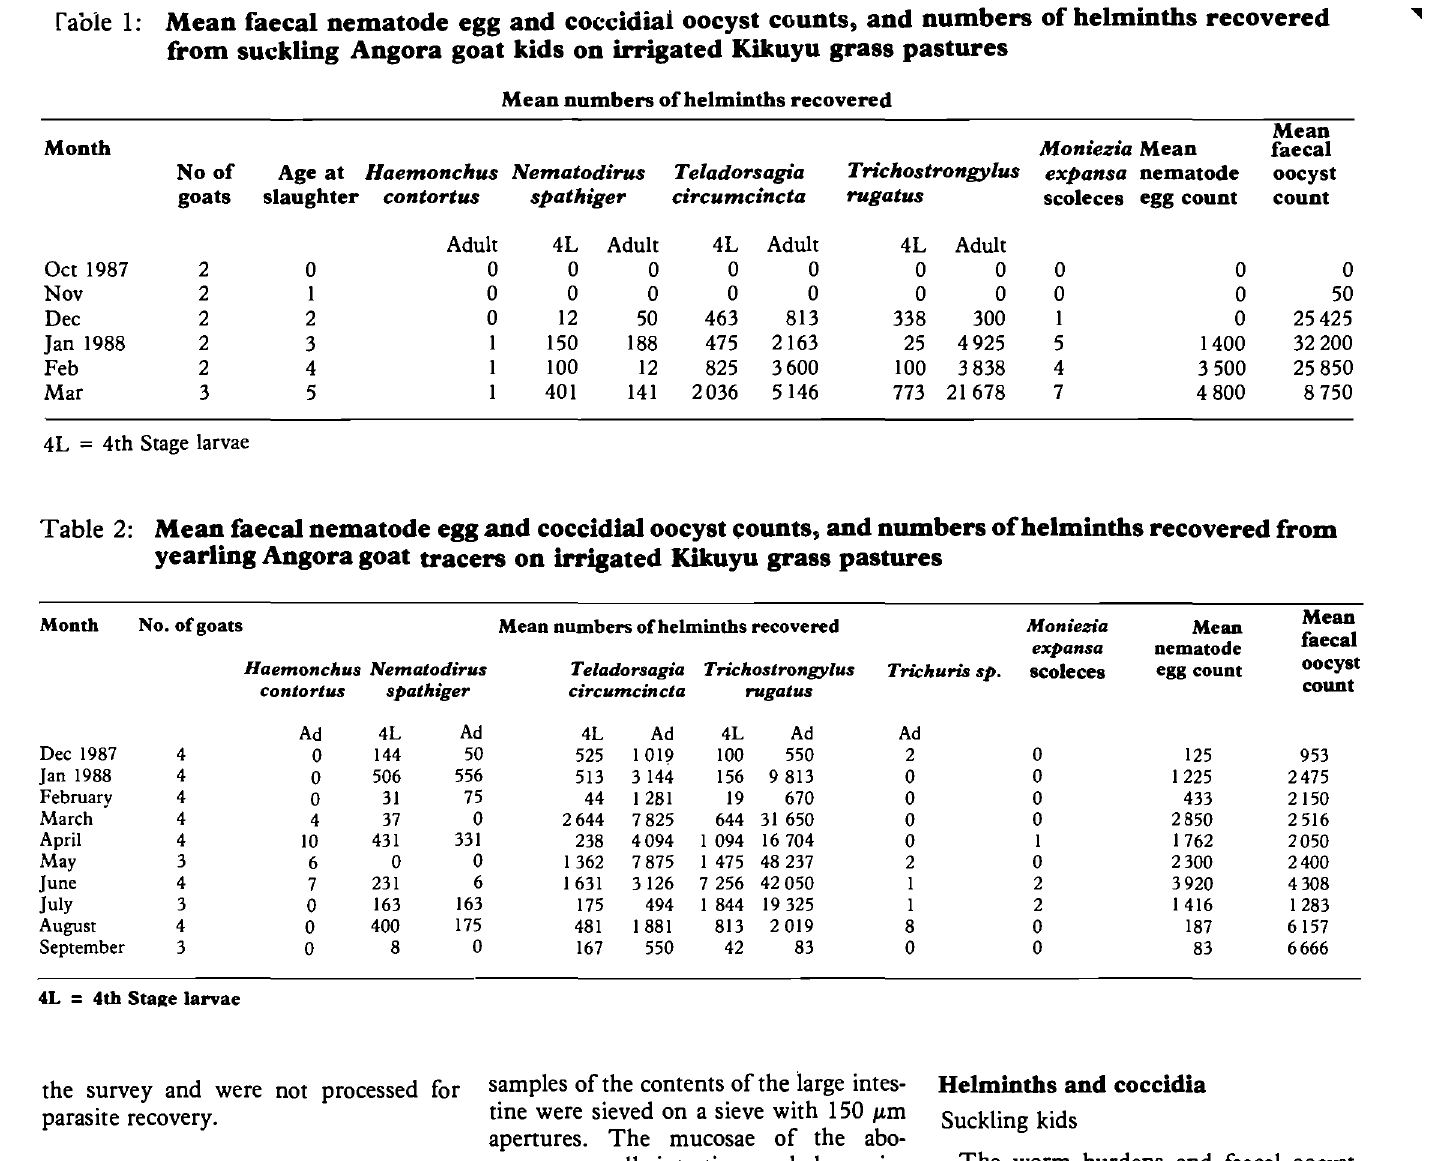
Table 2: Mean faecal nematode egg and coccidial oocyst counts, and numbers of helminths recovered from yearling Angora goat tracers on irrigated Kikuyu grass pastures Month No. of